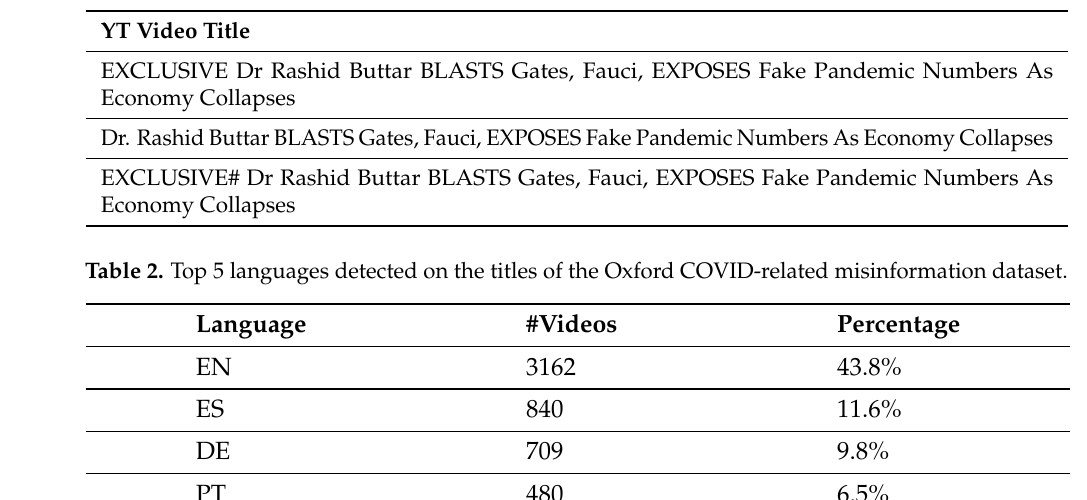
Table 1. Duplicate videos.